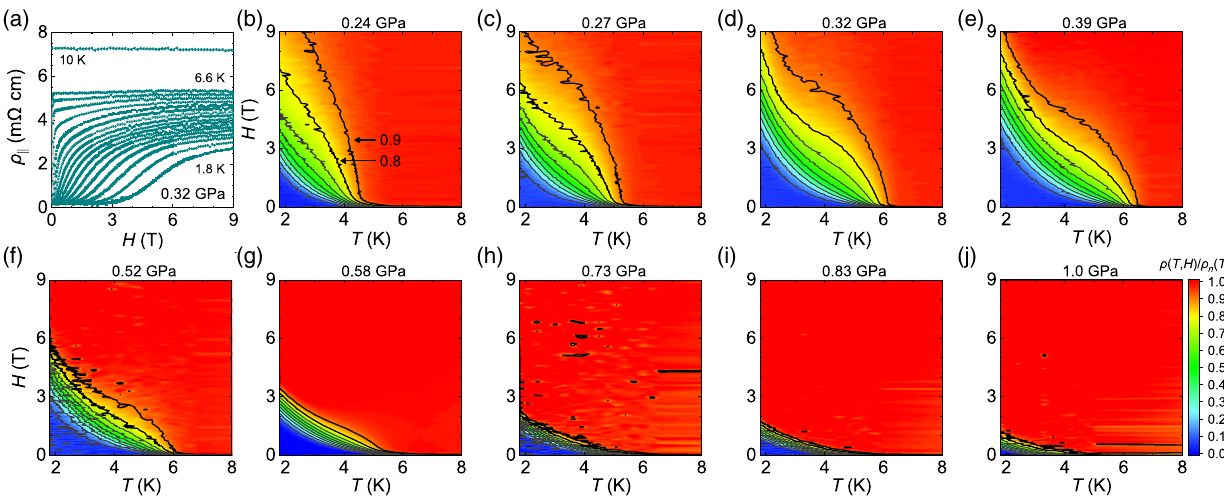
FIG. 3. Resistivity under magnetic field. (a) In-plane resistivity as a function of magnetic field H applied perpendicular to the layers under the pressure of 0.32 GPa. The temperature was set to the temperatures between 1.8 and 6.6 K at 0.3 K intervals and to 10.0 K. (b) – (j) Contour plots of the normalized in-plane resistivity, ρ ð T; H Þ = ρ n ð T Þ , in the temperature – magnetic-field ( T - H ) plane for the pressure of 0.24, 0.27, 0.32, 0.39, 0.52, 0.58, 0.73, 0.83, and 1.0 GPa, where ρ ð T; H Þ is the in-plane resistivity at T and H and ρ n ð T Þ is the normal resistivity with the form of ( ρ 0 þ AT α ) fitting the high-field data (see text). The solid lines indicate the contours of ρ ð T; H Þ = ρ ( H - T ) plane at each pressure is shown in the contour plot of the reduced resistivity ρ ð T; H Þ = ρ n ð T Þ , where ρ n ð T Þ is the normal-state resistivity determined in Figs. 3(b) – 3(j). In the blue area, the resistivity vanishes or is small. As the magnetic field increases, the system enters the mixed state with mobile vortices, ρ ð T; H Þ = ρ n ð T Þ takes finite values (light blue to yellow area), and eventually, the normal-state resistivity is restored, i.e., ρ ð T; H Þ = ρ n ð T Þ ≈ 1 (red area). In